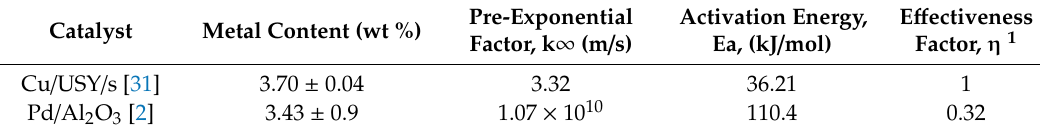
Table 2. Catalyst preparation and kinetic data.